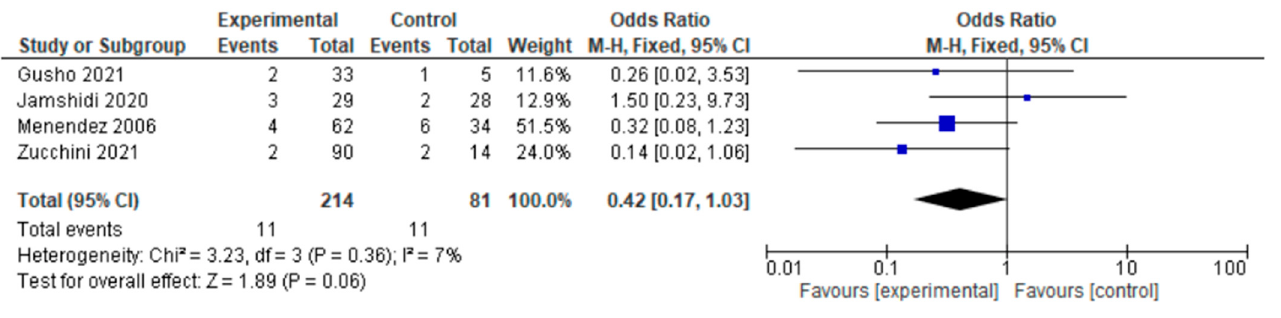
Figure 2. Forest plot of dislocation comparing in proximal femur tumor patients undergoing HA and THA.